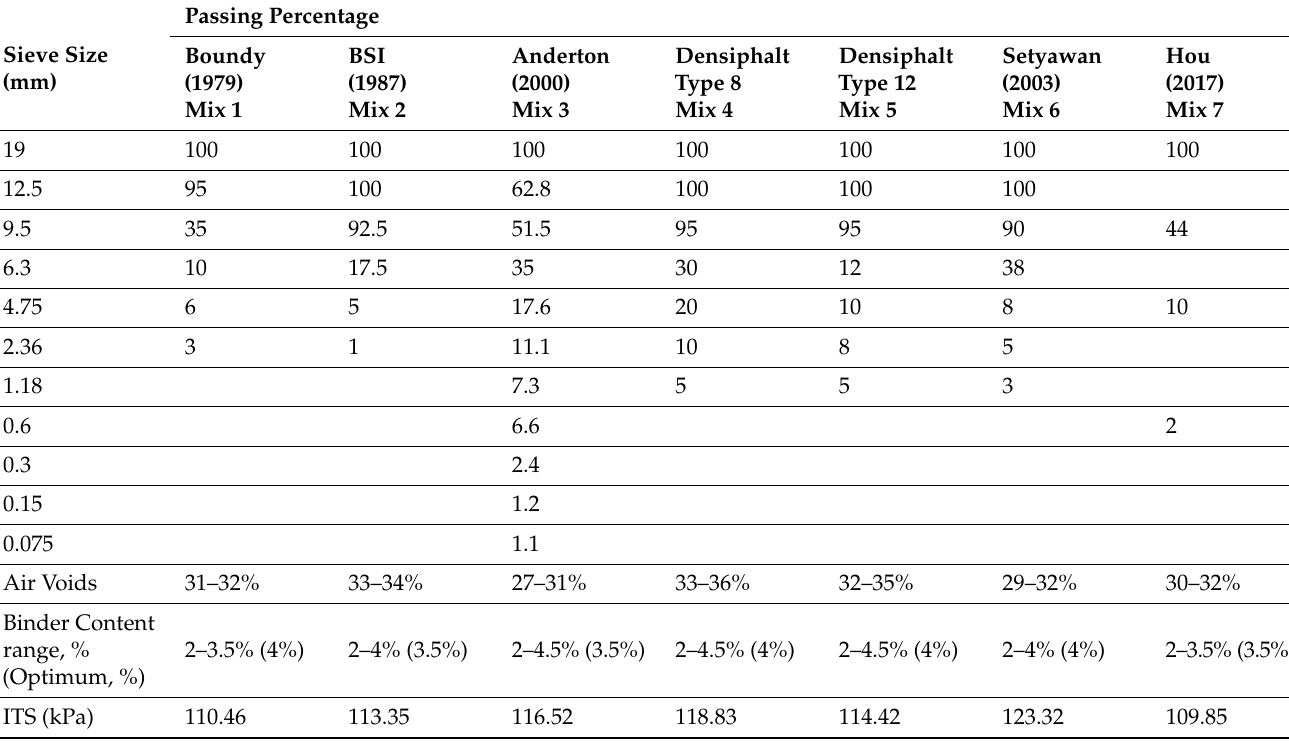
Table 3. Gradation adopted by Saboo at.al. (2019) [51].